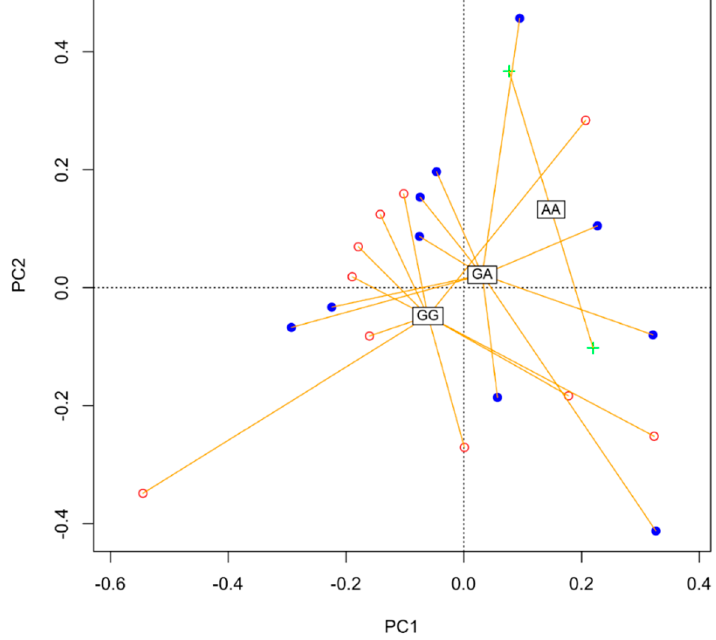
Figure 7. Differences in the composition of the microbiome depending on the FUT2 gene (principal coordinates analysis (PCoA)).